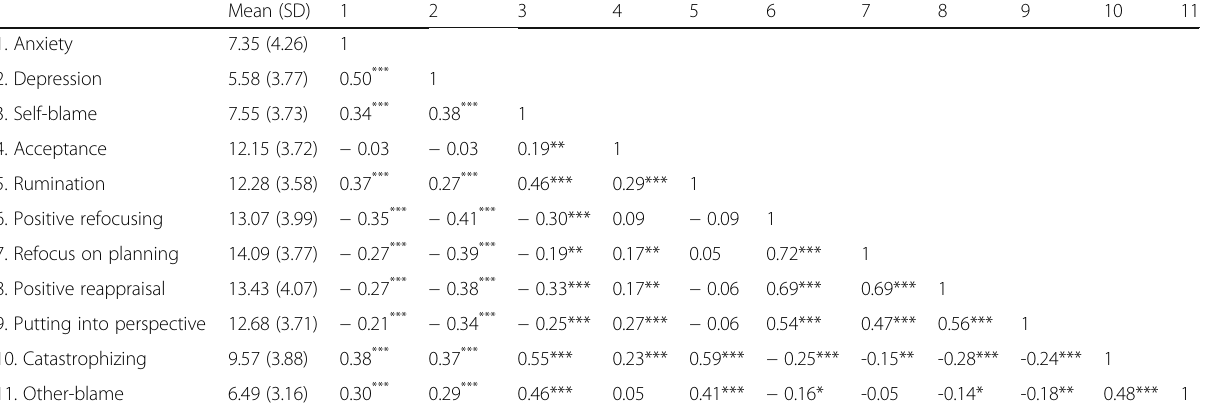
Table 2 Means, standard deviations, and correlations among study variables ( n = 240)